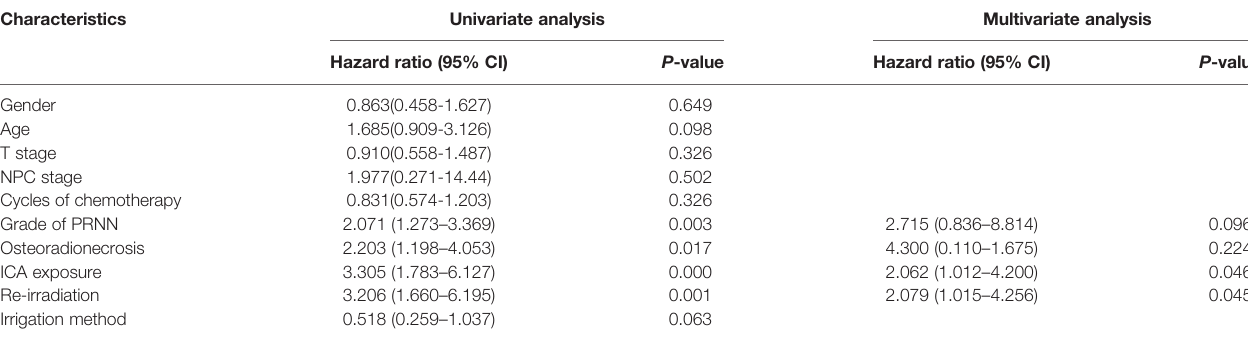
TABLE 2 | Univariate and multivariate analyses of variables associated with overall survival (OS).